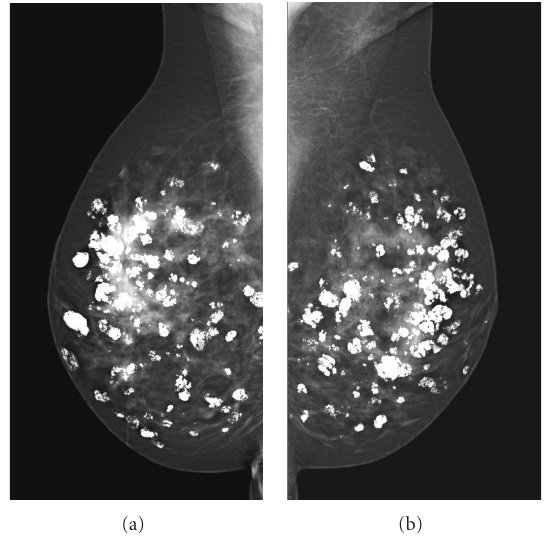
Figure 4: Patient’s sister mammography (mediolateral oblique direction shown) showed massive calcifications in multiple, well- defined masses, some of them with adipose tissue, diagnostic of